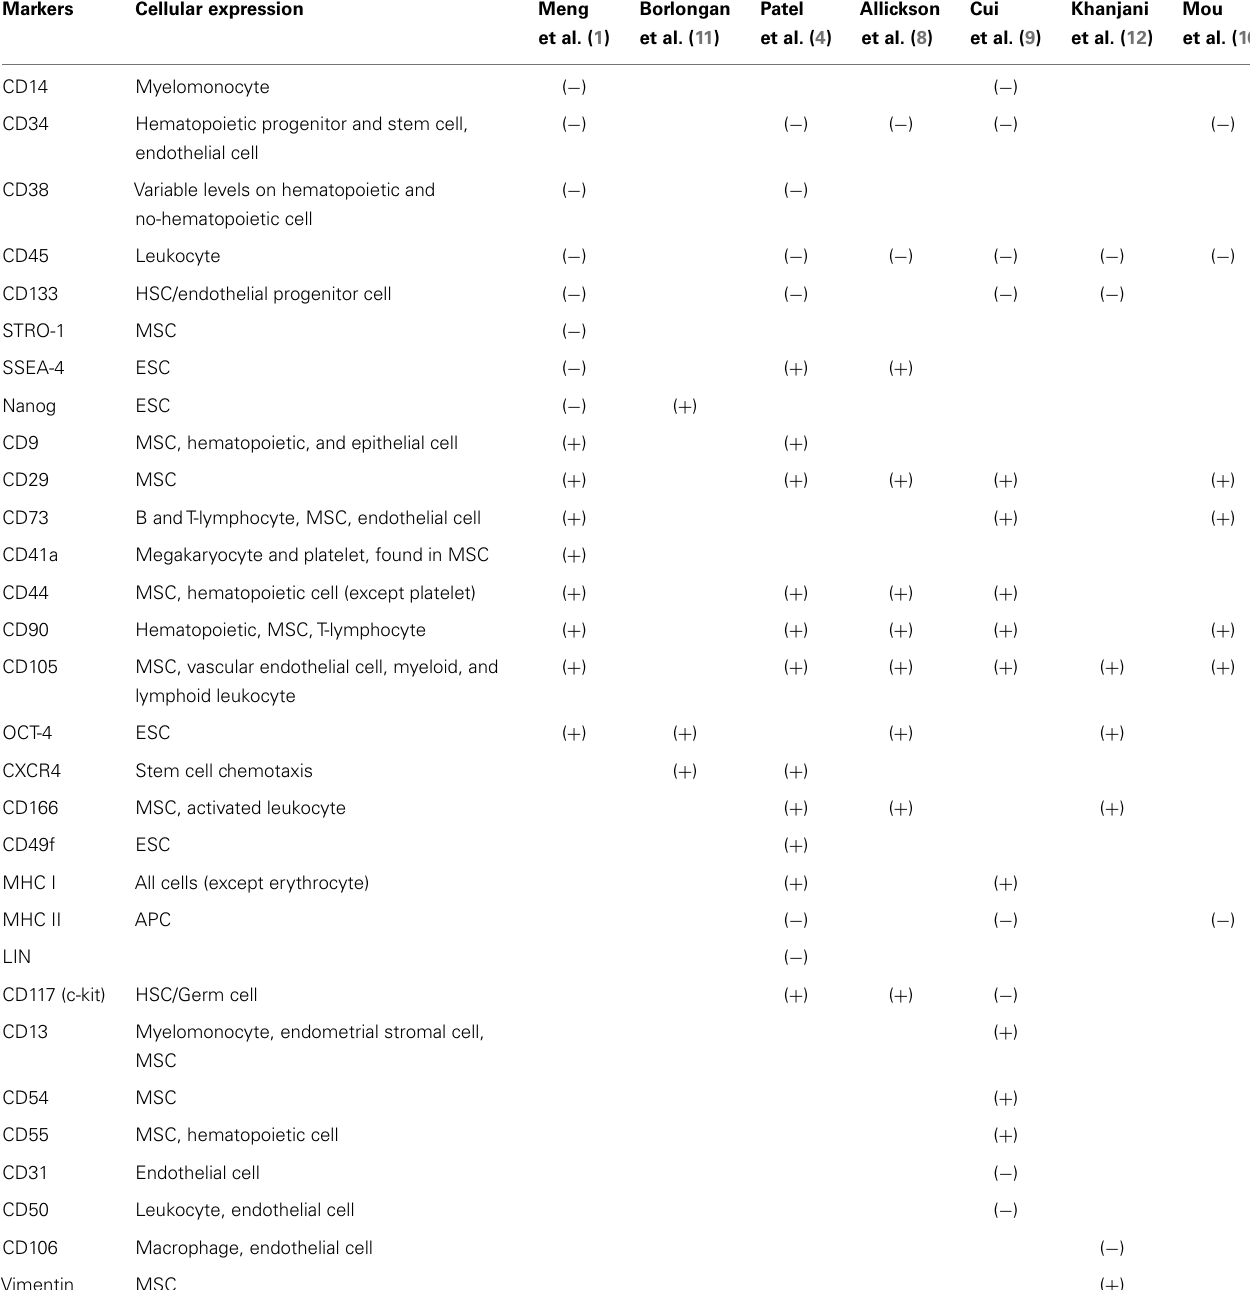
Table 1 | Comparison of the different immunophenotypic profile of MenSCs .